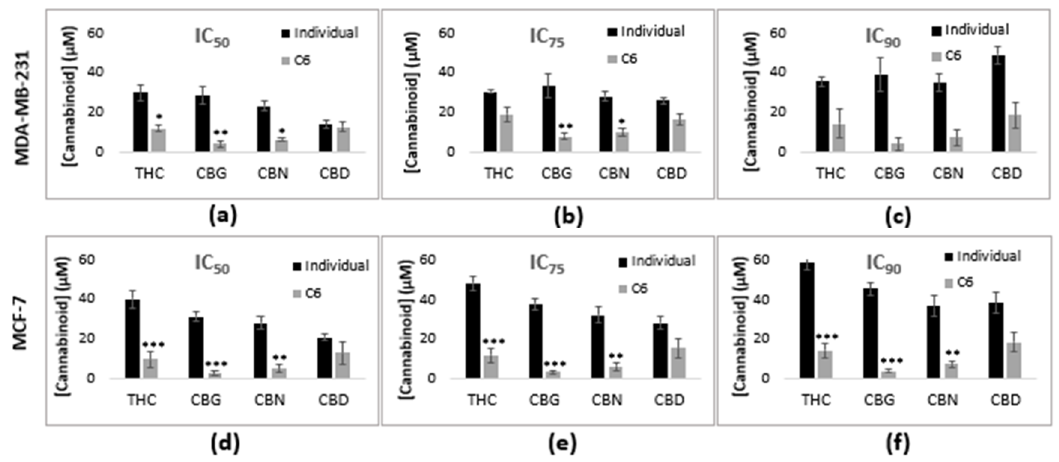
Figure 5. Comparison of the concentration of each cannabinoid, individually and in combination, required to induce a ( a , d ) 50%, ( b , e ) 75%, and ( c , f ) 90% growth inhibition in the ( a – c ) MDA-MB-231 and ( d – f ) MCF-7 cell lines. * p < 0.05, ** p < 0.01, *** p < 0.001 relative to the respective cannabinoids used individually.